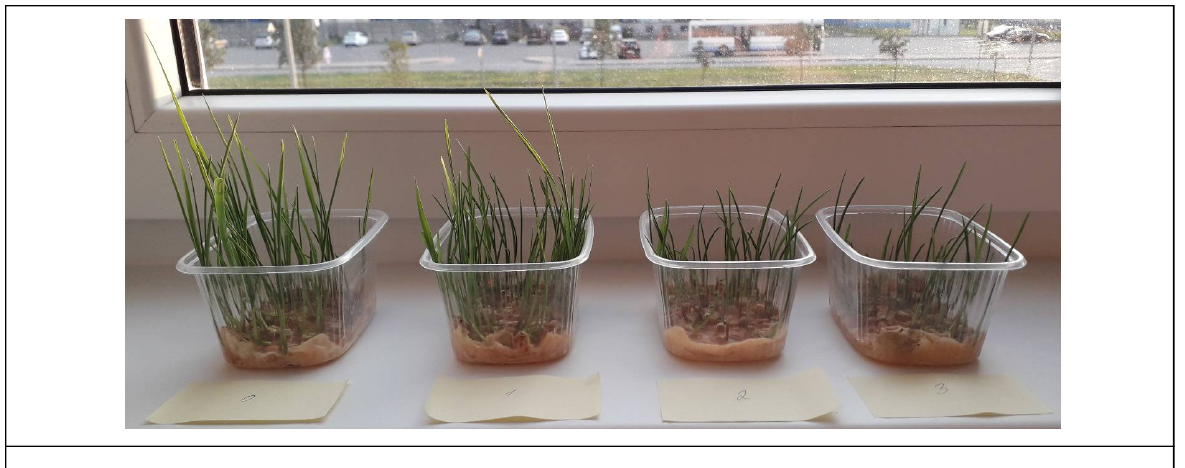
Figure 9: Tríticum durum on ordinary and magnetized water (August 16,